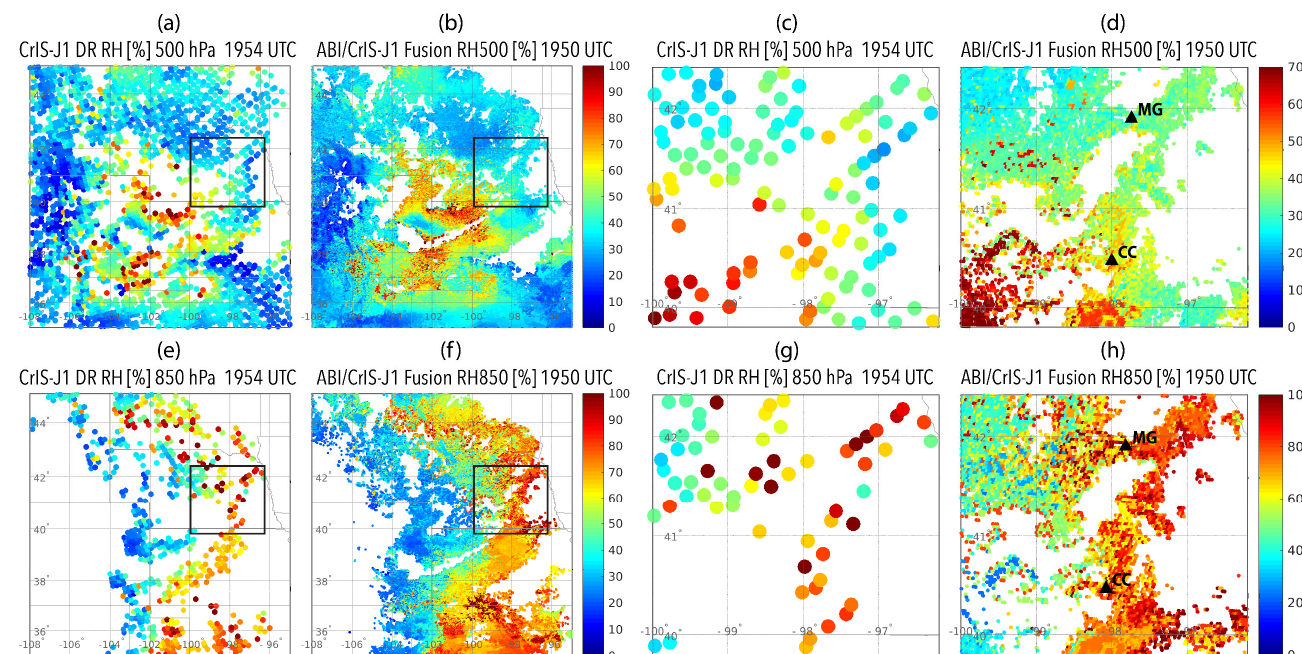
Figure 2. Relative humidity (RH) in [%] for the 500 hPa ( a – d ) and the 850 hPa ( e – h ) pressure levels on 5 May 2021. RH retrievals derived from CrIS on JPSS-1 are shown in ( a , e ), and the boxed areas are shown enlarged in ( c , g ); ABI/CrIS RH fusion results are shown in ( b , f ), and the boxed areas are shown enlarged in ( d , h ), where the towns of Meadow Grove and Clay Center (Nebraska) are marked as black triangles.